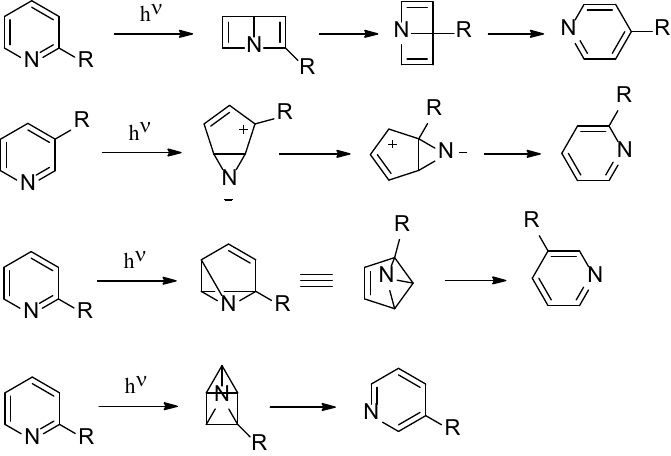
Figure 1. Proposed photoisomerization routes for hexatomic heterocycles.